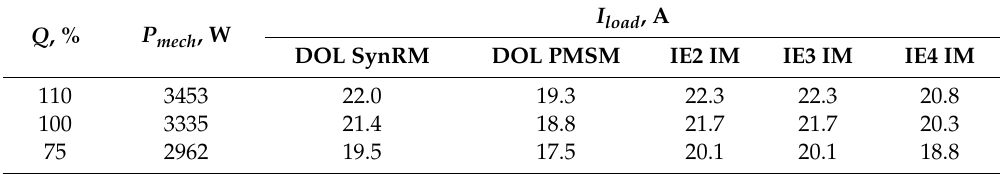
Table 5. The current of three motors with various loading conditions of the duty